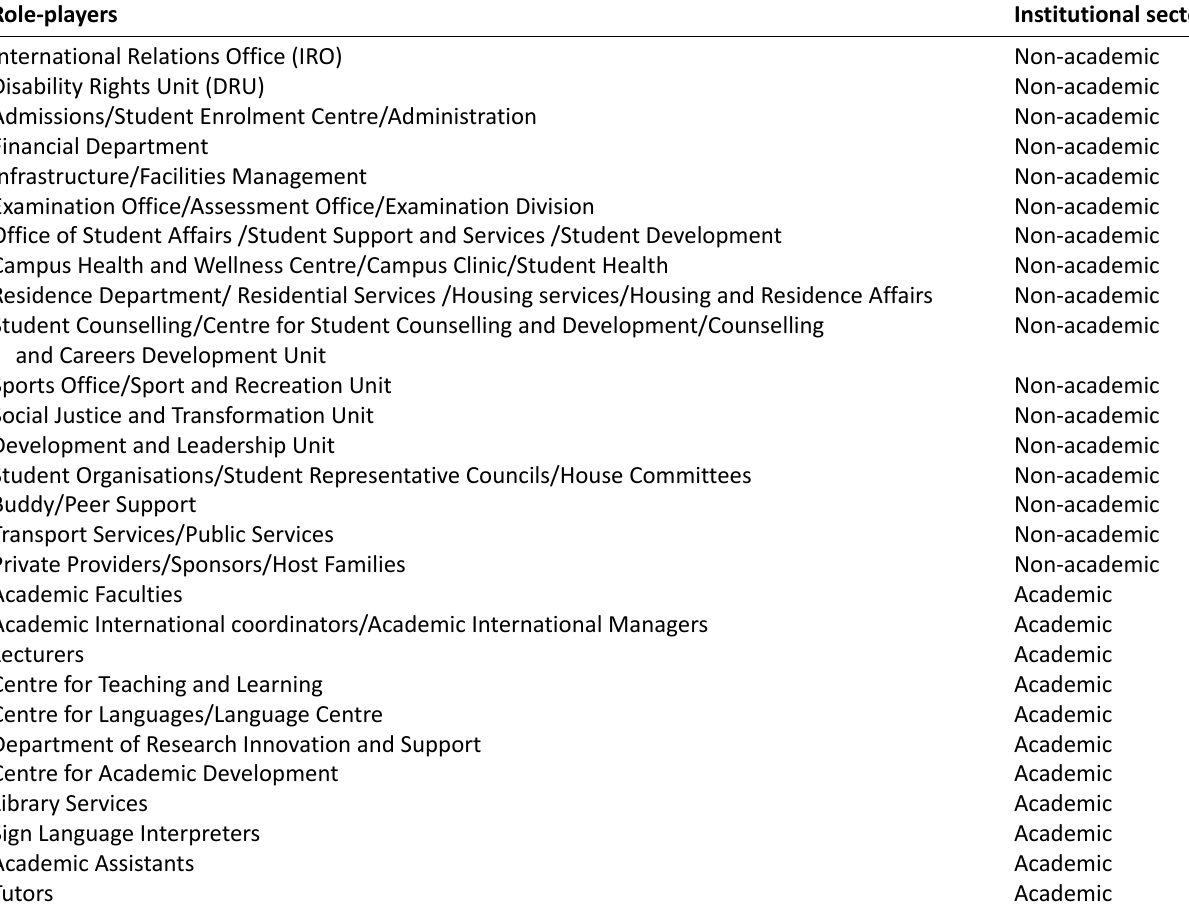
Table 1. Role-players that support international students with disabilities at the respondent institutions.